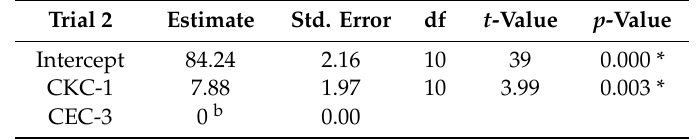
Table 15. The significant di ff erence of mean scores obtained in Trial 2 between CKC-1 and CEC-3. Trial 2 Estimate Std. Error df t -Value p -Value Intercept 84.24 CKC-1 3.99